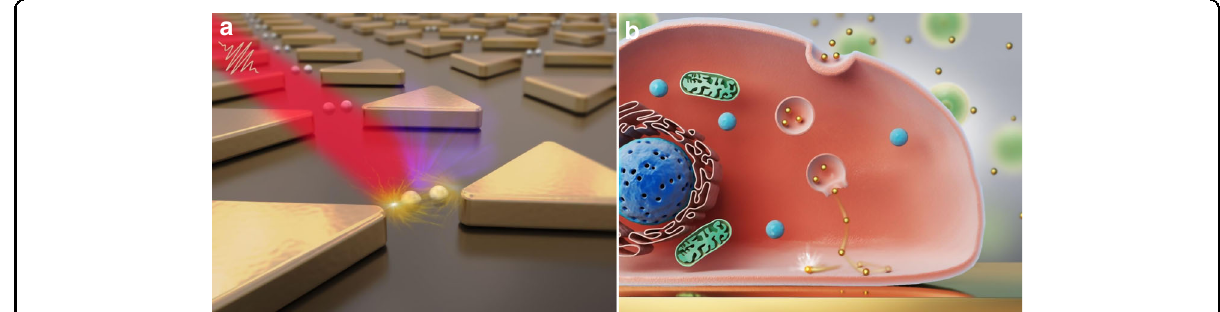
Fig. 18 Future outlook and applications. a Nonlinear plasmonic trapping and its applications. The nonlinear light – matter effect disrupts plasmonic excitation and propagation along a surface. Secondary nonlinear plasmon – matter interactions then generate new nonlinear phenomena. b Intracellular detection with plasmonic tweezers. Nanoscale particles can be endocytosed by biological cells and manipulated intracellularly across a cell membrane. Owing to the enhancement of the electromagnetic fi eld, label-free Raman spectral signals can be detected from inside the